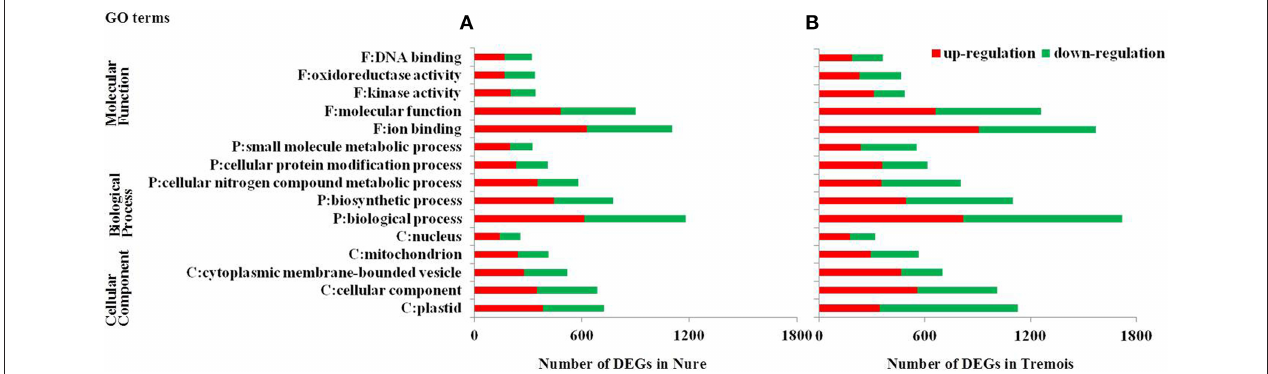
FIGURE 3 | Gene Ontology (GO) analysis of differentially expressed genes (DEGs) in Nure (A) and Tremois (B). F, Molecular Function; P, Biological Process; C, Cellular Component; DEGs, differentially expressed genes. Only the top five GO terms in each of the three major categories, molecular function, biological process, and cellular component, are